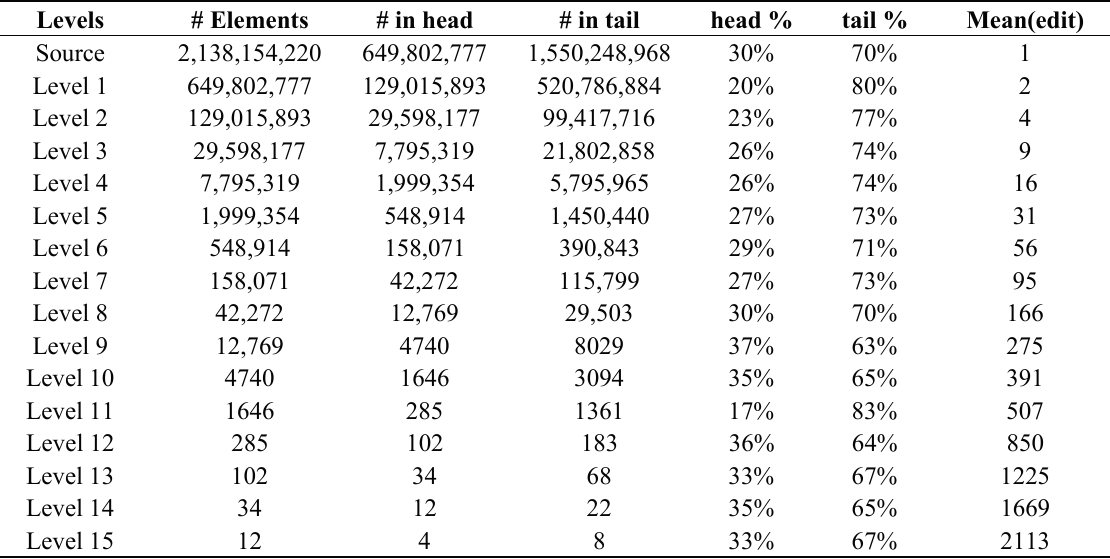
Table A2. Head/tail breaks statistics for number of edits of each element.